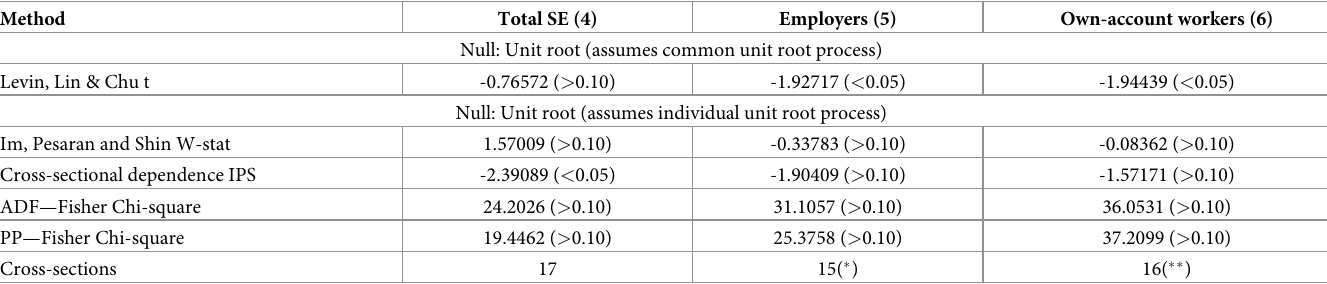
Table 2. Panel unit root test result native vs